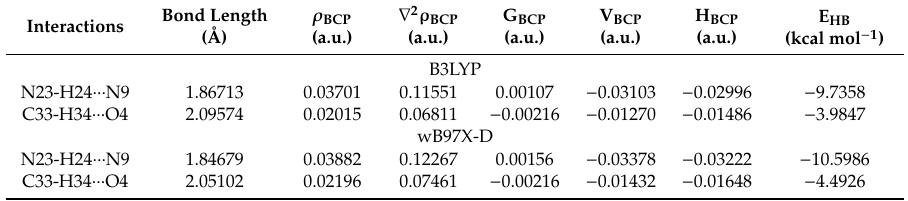
Table 1. Geometrical (calculated bond length) and topological parameters for hydrogen bonds